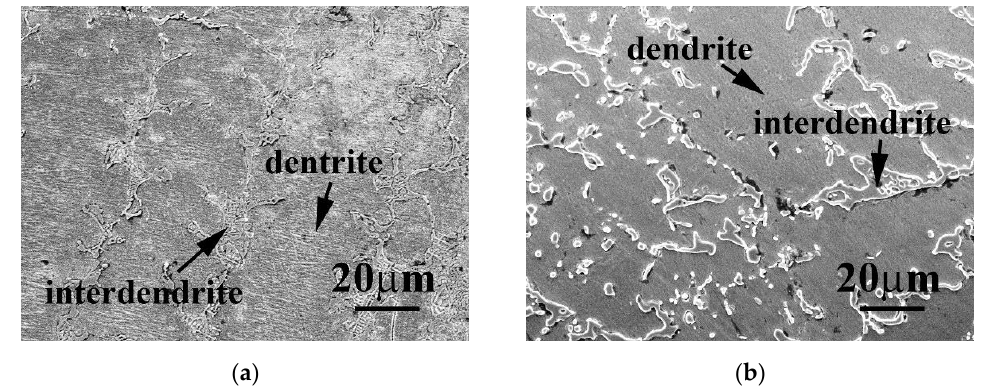
Figure 1. SEM micrographs of Cr 27 Fe 24 Co 18 Ni 26 Nb 5 alloy in the ( a ) as-cast state, and ( b ) after annealing at 1000 °C for 24 h . Table 1. Chemical compositions of the phases in the Cr 27 Fe 24 Co 18 Ni 26 Nb 5 alloy analyzed by SEM/EDS in atomic percentage.